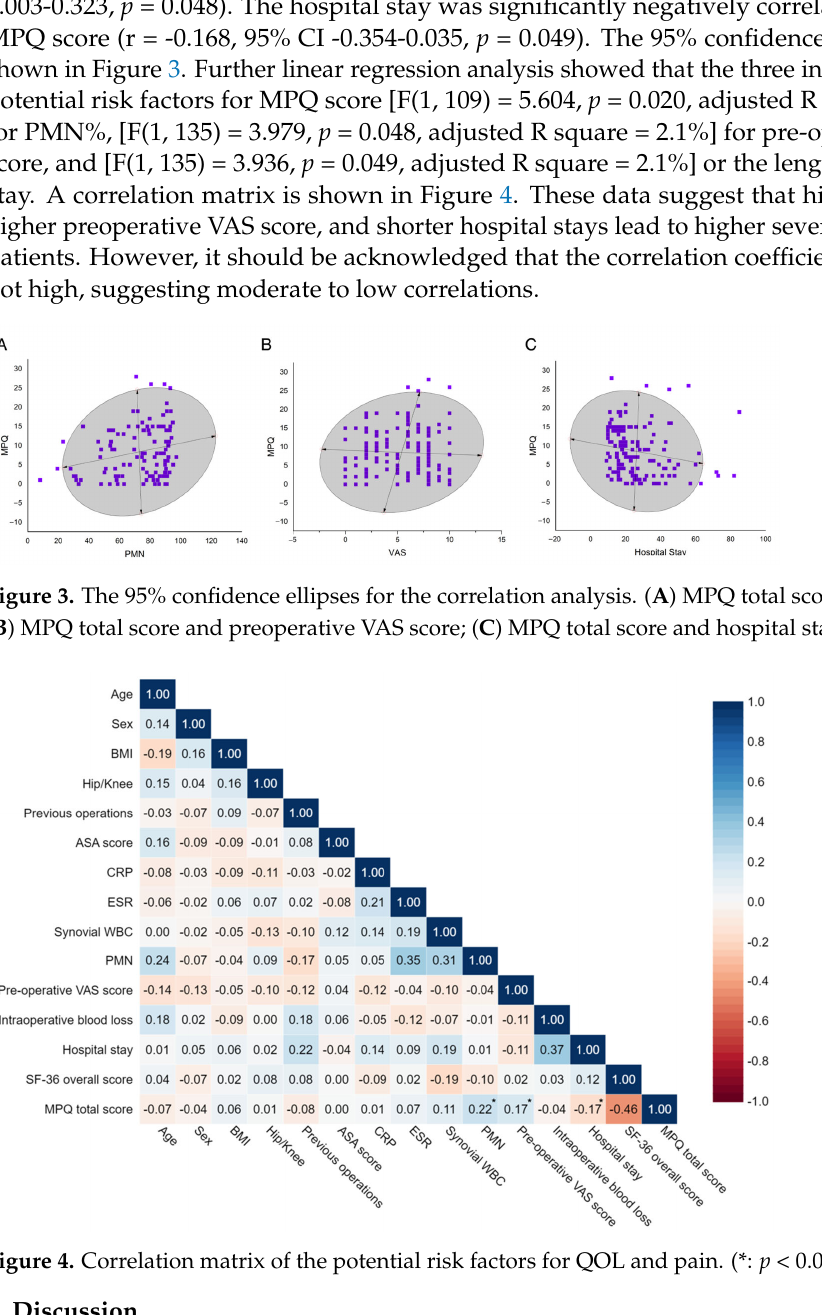
Figure 4. Correlation matrix of the potential risk factors for QOL and pain. (*: p < 0.05)